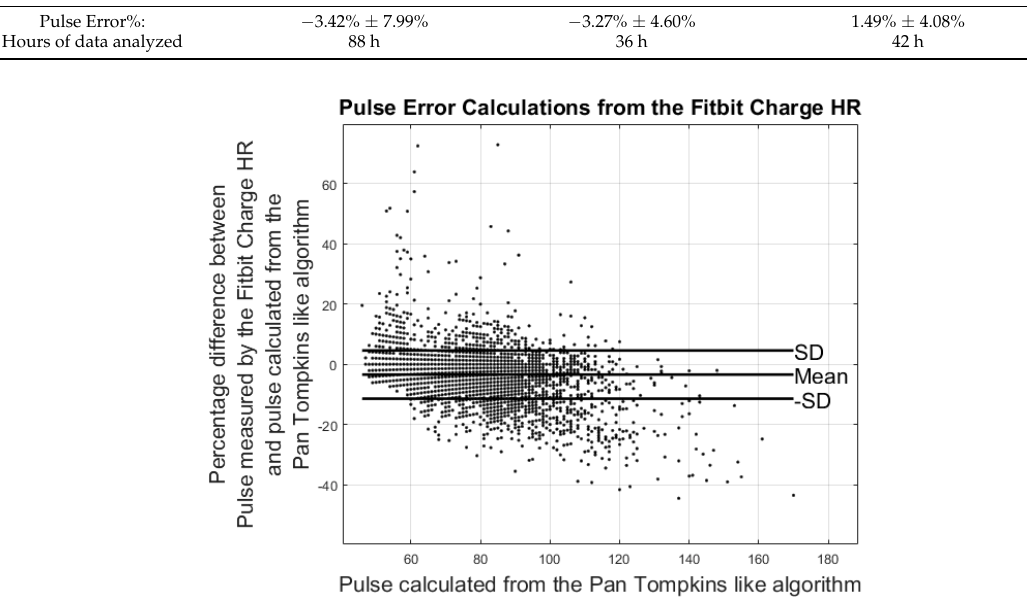
Figure 7. Results from the heart rate study: the plot shows percentage differences in the average pulse calculated from the Fitbit Charge HR and the Pan Tompkins-like algorithm.